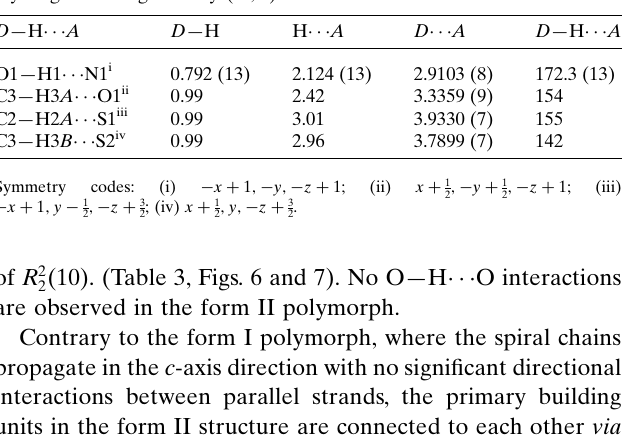
Table 2 Hydrogen-bond geometry (A˚ , (cid:3) ) for the 150 K structure.